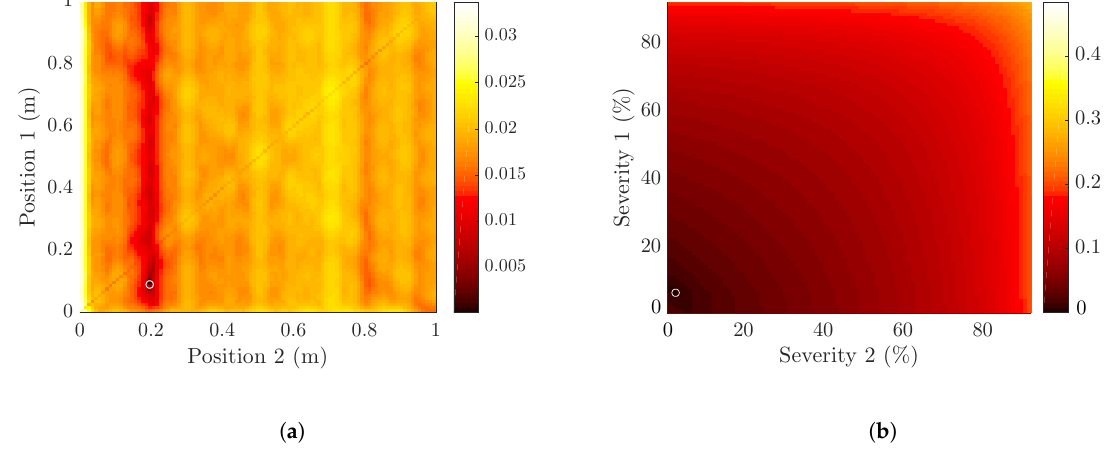
Figure 12. FSC as a function of tested multiple damage positions and severities ( a ) the white circle indicates that damage positions are 0.45 m and 0.55 m, ( b ) and severities of localized damages are 7% and 2%.